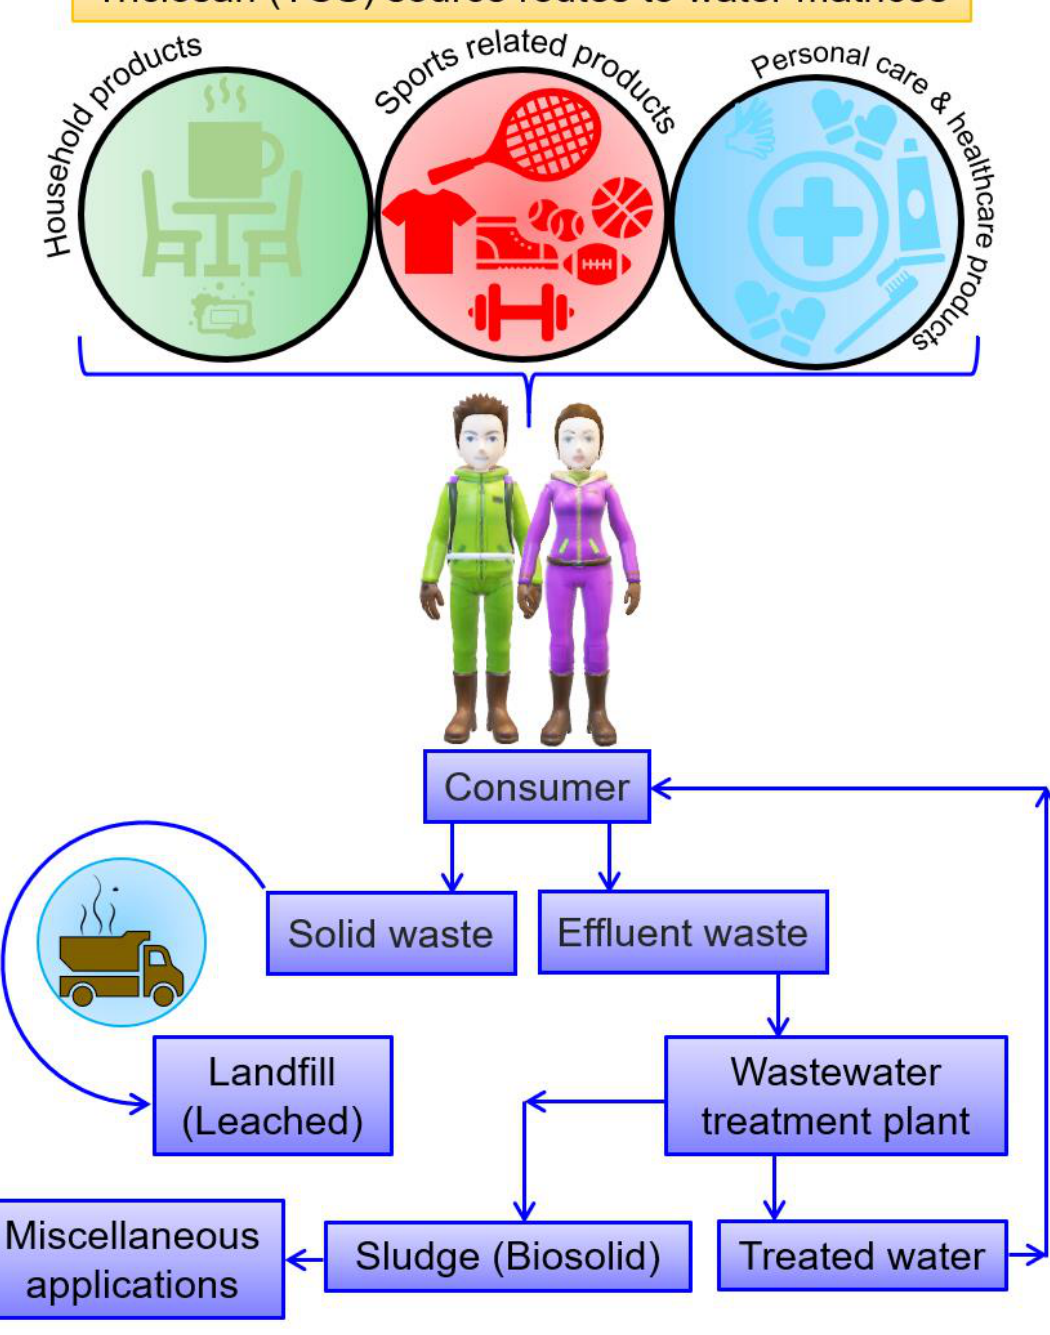
Figure 1. Schematic illustration of the fate and general distribution of Triclosan (TCS) in water matrices.